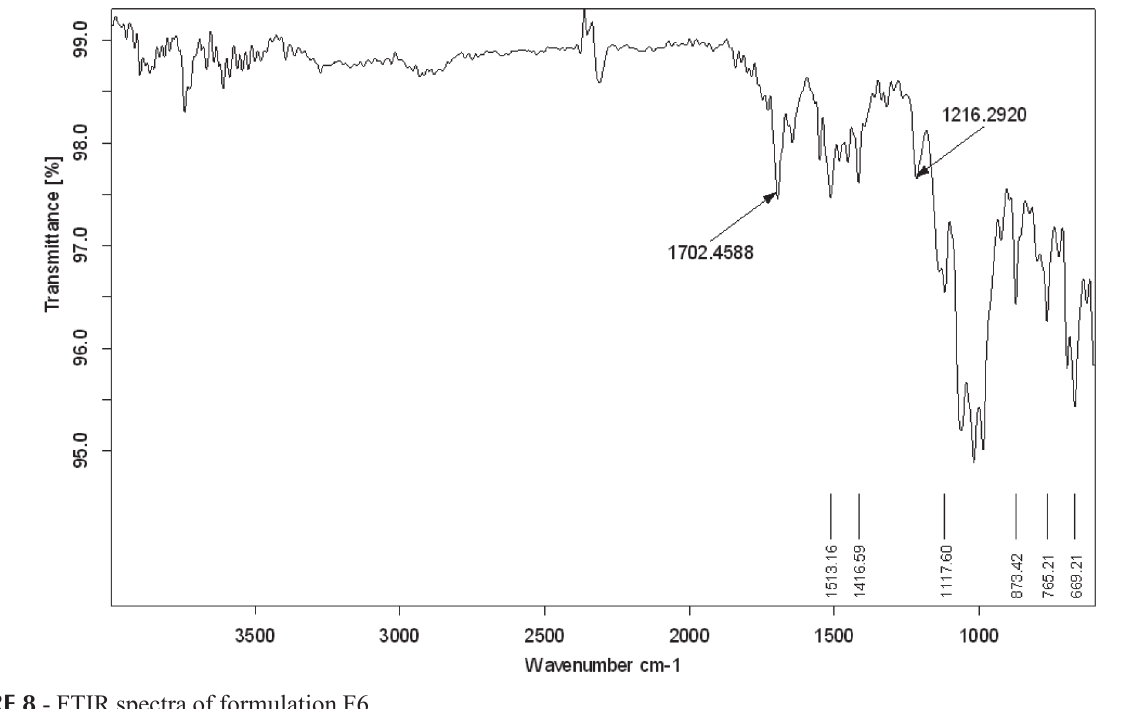
FIGURE 8 - FTIR spectra of formulation F6.